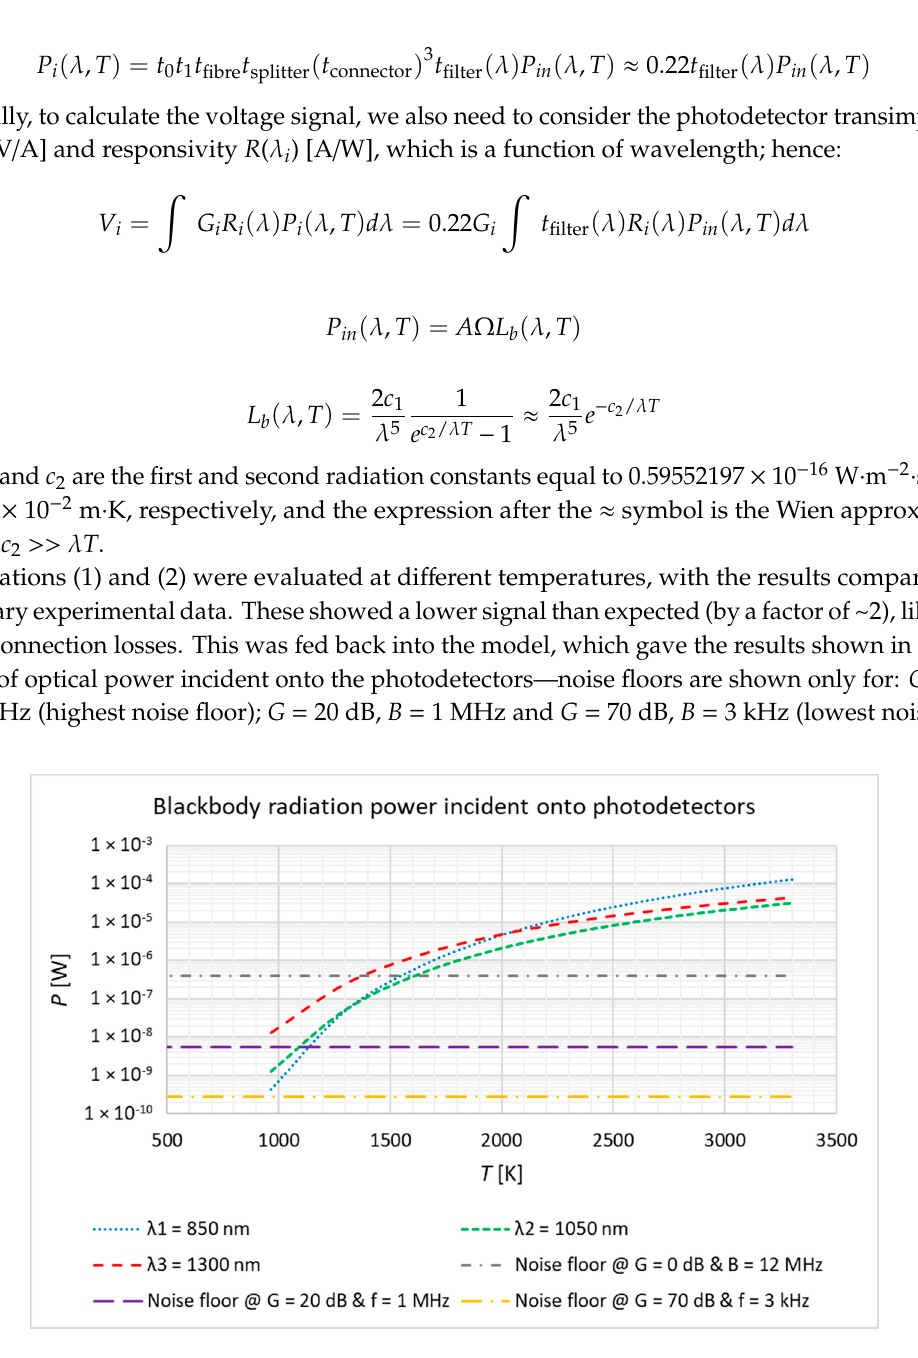
Figure 4. Blackbody radiation power incident onto photodetectors as a function of blackbody temperature.